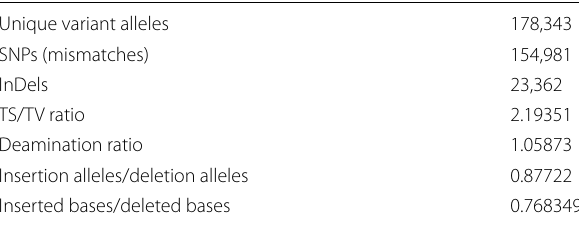
Table 3 The quality control parameters of variant calling format (VCF) file of the